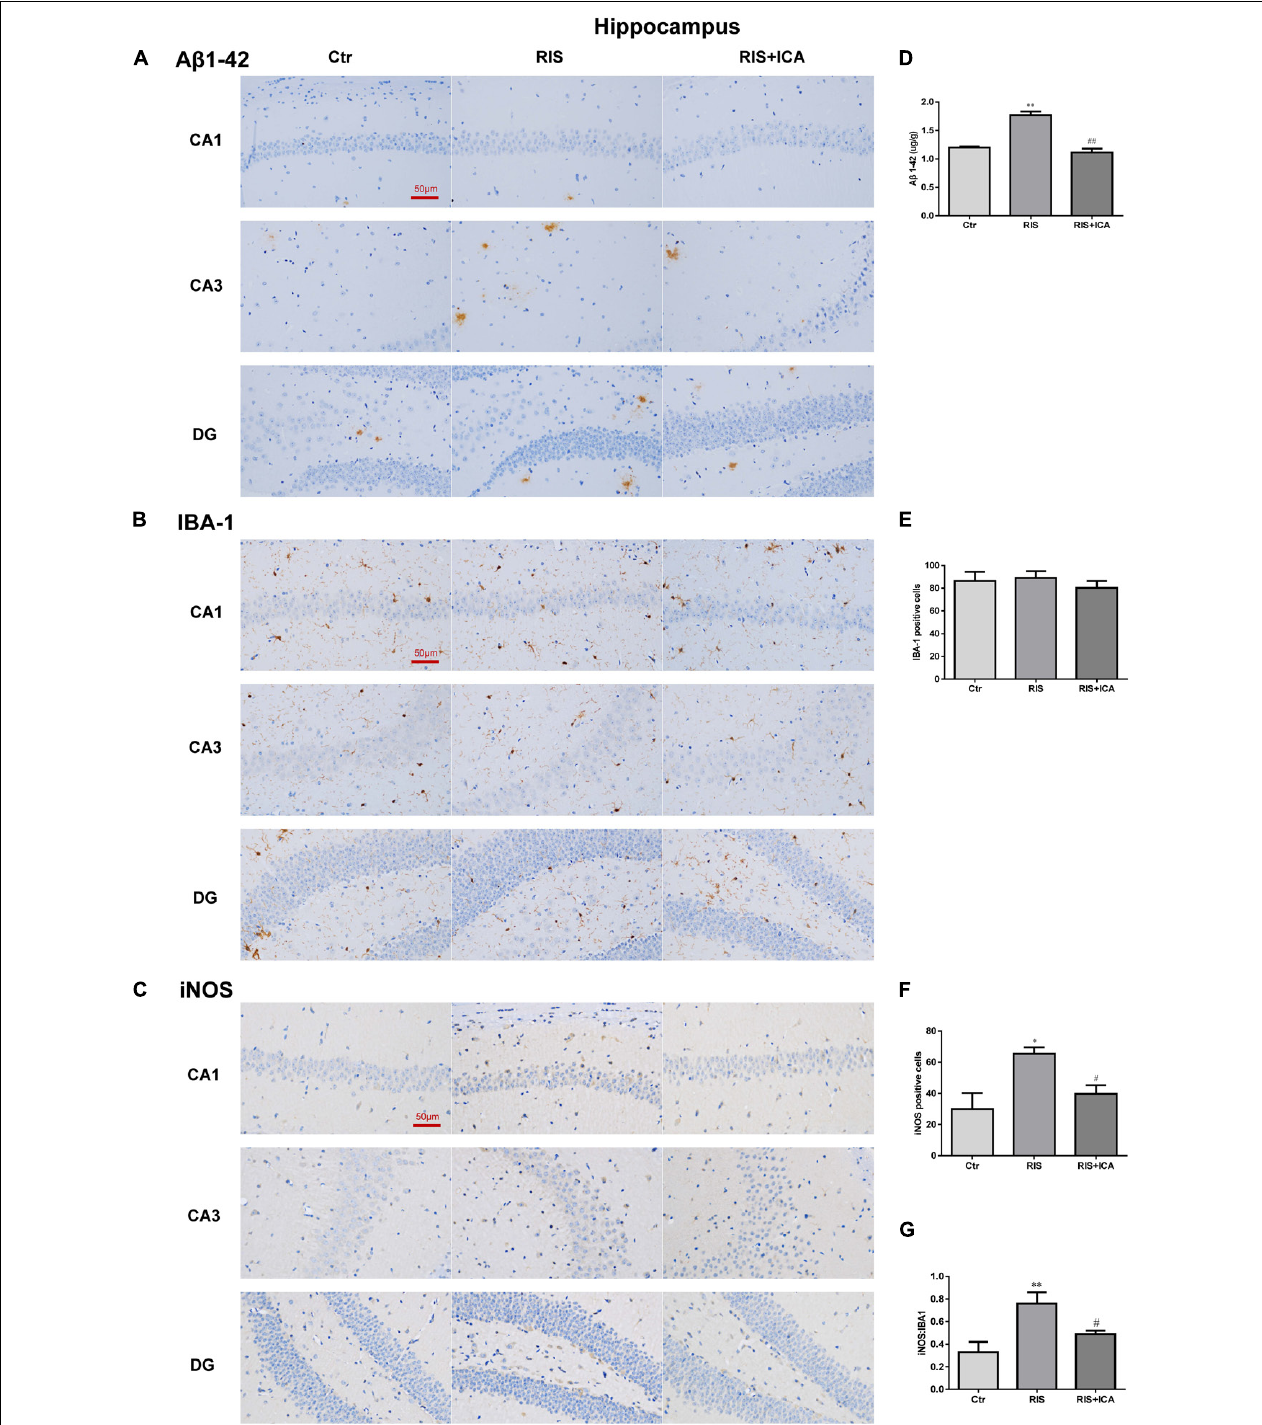
FIGURE 6 | Effect of icariin on A β plaques and microglia phenotype in the hippocampus. (A–C) The immunohistochemical staining results of A β , Iba-1, and iNOS (400 × ). (D) RIS significantly increased the levels of A β in the RIS group compared with the controls, and administration of icariin decreased its levels in the RIS+ICA group. (E) The number of Iba-1+ microglia positive cells was not significantly different among the three groups. (F) The number of iNOS+ microglia positive cells in the hippocampus of stressed mice was higher than that of control mice, and icariin administration reversed the change in the RIS+ICA group. (G) The RIS group showed higher ratio of iNOS+ to Iba-1+ microglia, while the RIS+ICA group showed a lower ratio. The results of A β are expressed as the mean ± SEM, n = 6; the results of Iba-1 and iNOS are expressed as the mean ± SEM, n = 4. ∗ p < 0.05, ∗∗ p < 0.01 vs. control group; # p < 0.05, ## p < 0.01 vs. RIS group.